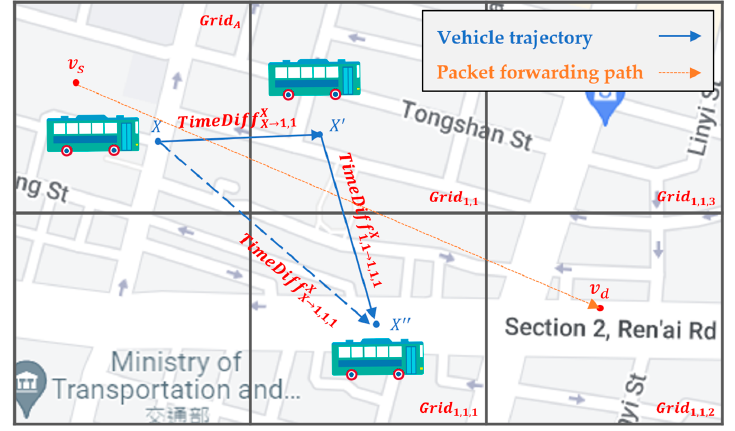
Figure 13. One-Two-Hop Value algorithm.